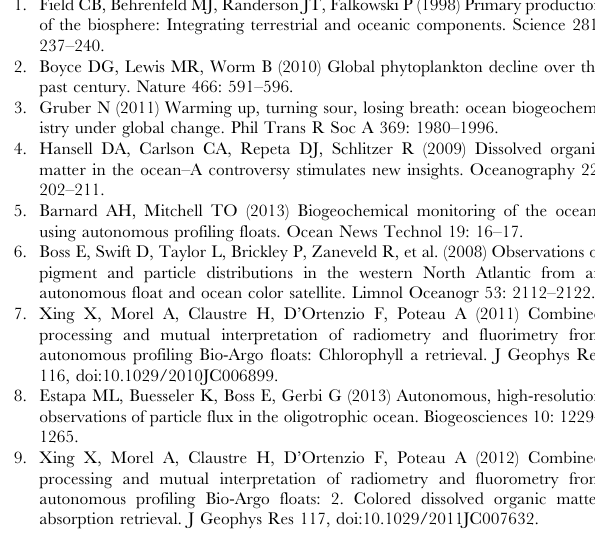
(C) CDOM. Bottom depth is shown for reference (shaded grey). Note that profiles are not evenly spaced in time (see Methods). (TIF) Figure S3 Contour plots of bio-optical profiles for the upper 200 m to emphasize upper-water column dynam- ics. (A) Chl, (B) b bp , and (C) CDOM. The reference density layer r = 1023.6 is shown (black line). Note that profiles are not evenly spaced in time (see Methods). The times corresponding to SSHA imagery in Fig. 1 are indicated in panel A (white dashed lines) to show where the float was located relative to the LC boundary. (TIF) Figure S4 Comparison of two physical-mixing indica- tors: the depth of the density layer r = 1023.6 and pycnocline depth. The pycnocline depth was calculated for each profile based on the maximum gradient in density in the upper 300 m of the water column. (TIF) Dataset S1 Float data used in this analysis. Text file contains the following columns: year, month, day, depth (m),